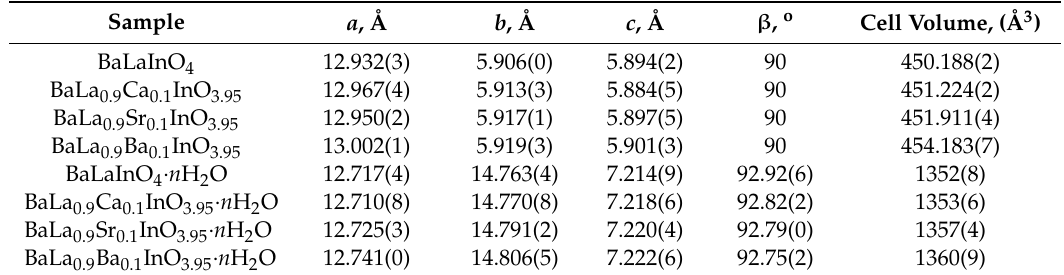
Table 1. Cell parameters and volume of anhydrous and hydrated samples.